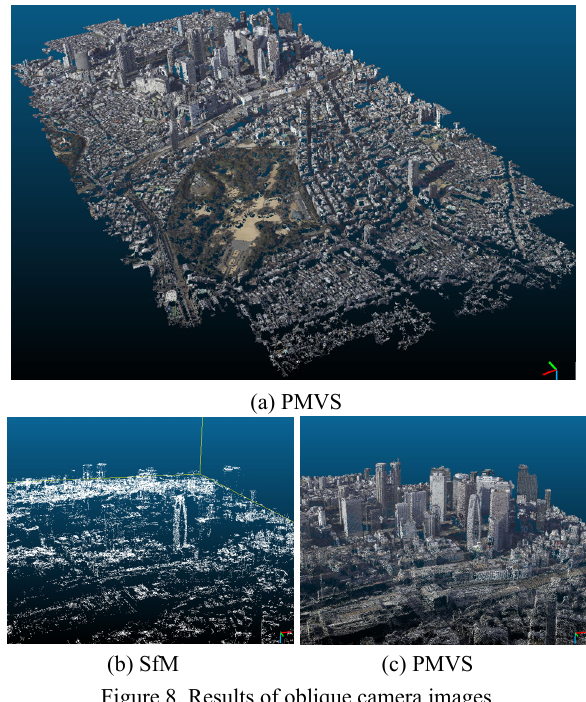
Figure 8. Results of oblique camera